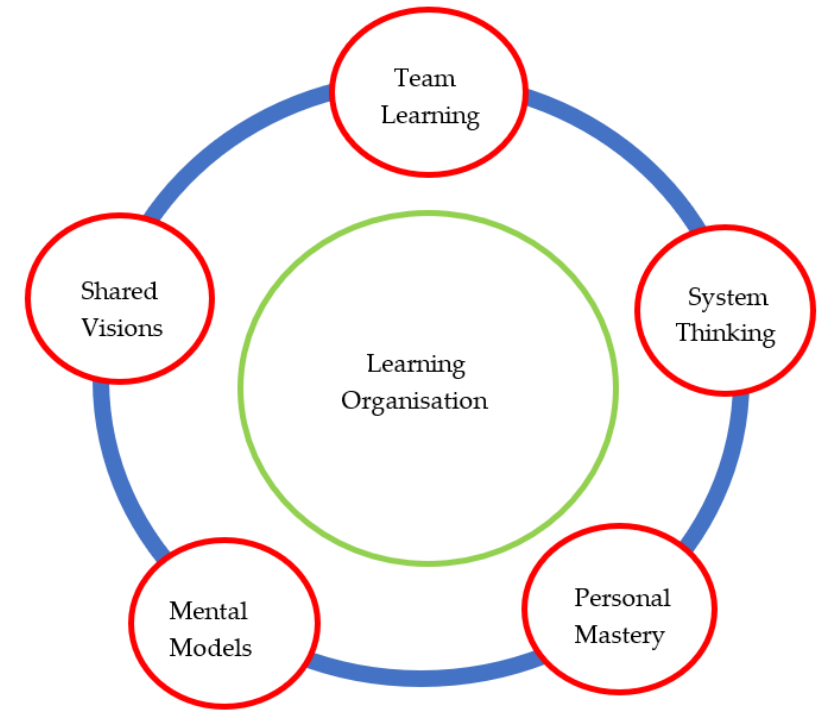
Figure 15. Five disciplines of a learning organization.